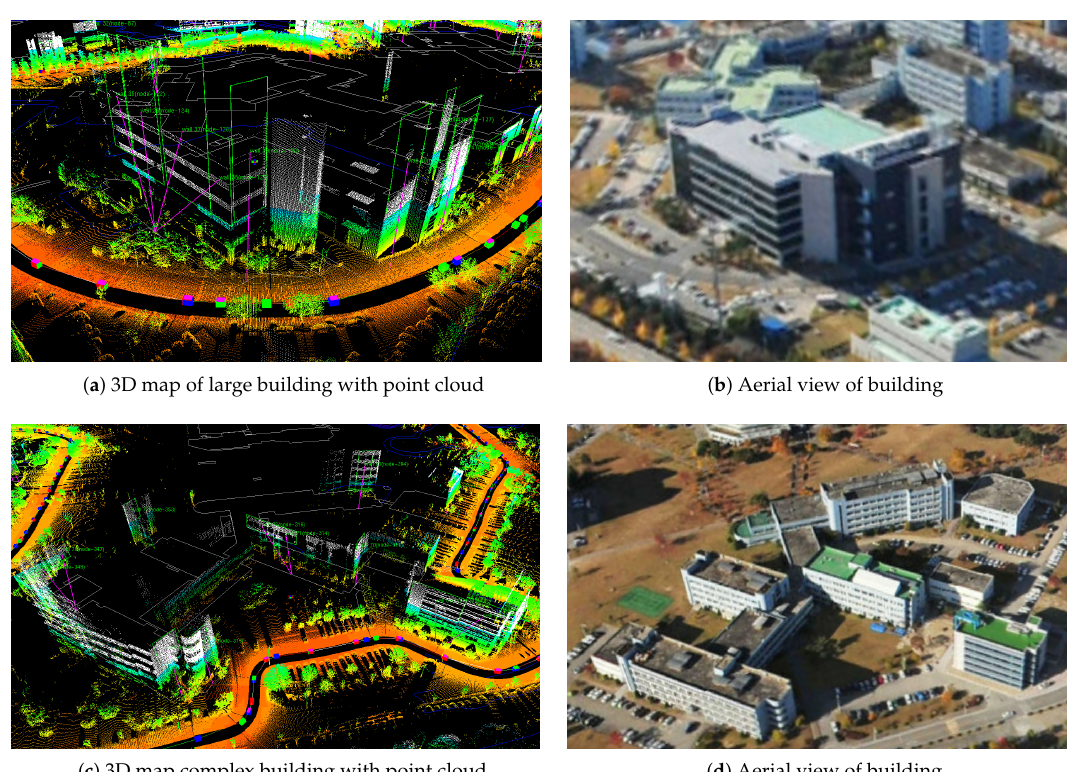
Figure 15. 3D mapping result for sample buildings. Accumulated and refined point cloud using SLAM trajectory is given. ( a ) and ( c ) are the 3D mapping of two samples. Points are colored by the height, and green squares indicate the classified building walls. ( b ) and ( d ) are the aerial view of each sample